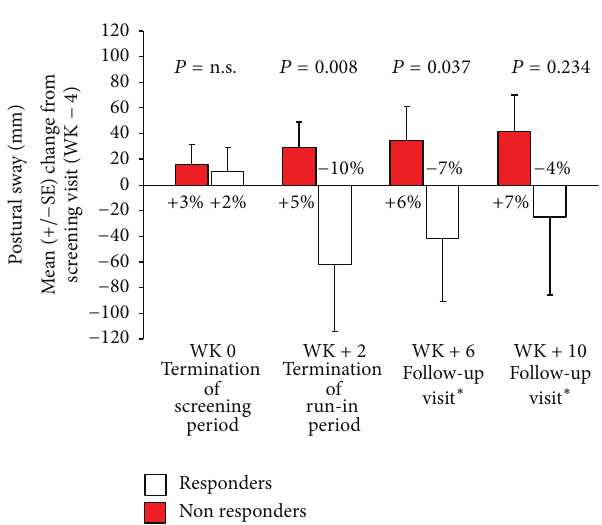
Figure 2: Mean absolute difference ( ± standard error, SE) in COP sway displacement (mm) from screening (WK − 2) value. Negative values refer to improved standing balance. SE: standard error. ∗ PR dalfampridine taken only by treatment